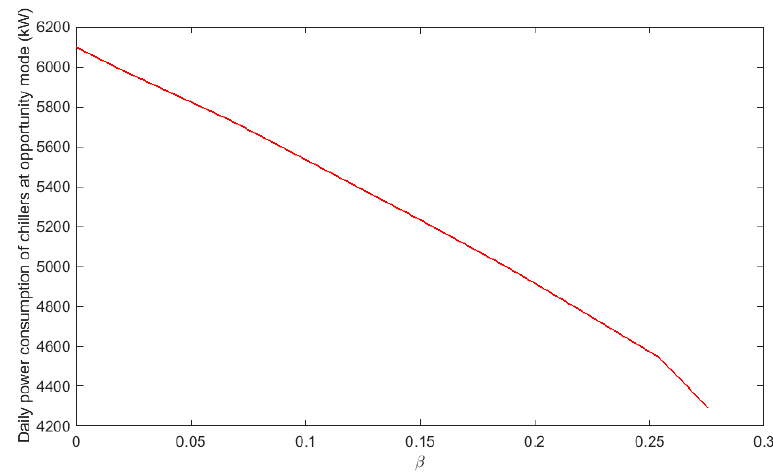
Figure 6. Daily power consumption of chillers versus 𝛼.